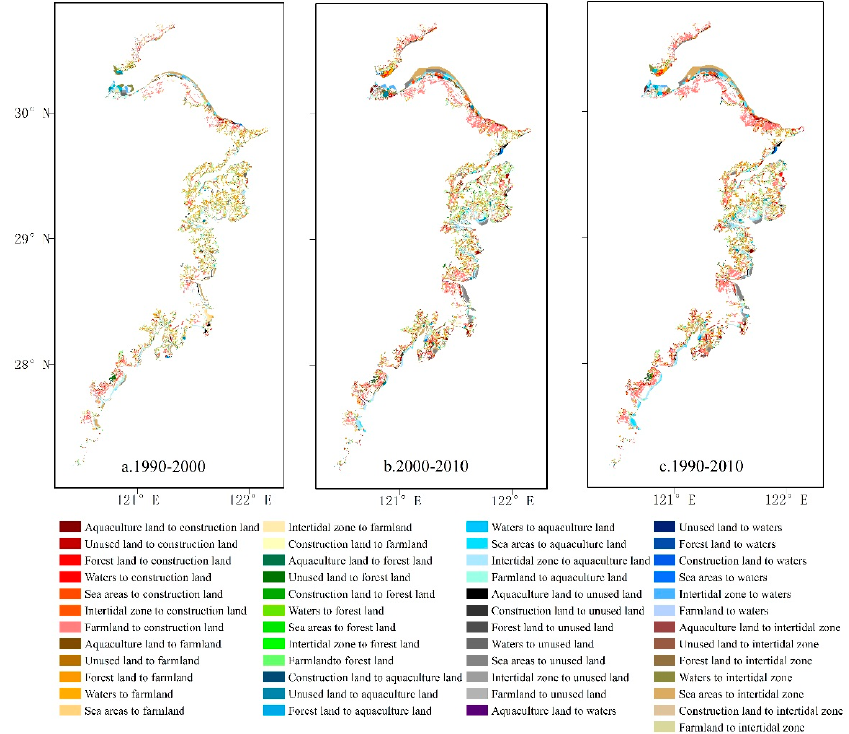
Figure 3. Land-use changes in the coastal zone in Zhejiang Province, 1990–2010. ( a ) land-use change from 1990 to 2000; ( b ) land-use change from 2000 to 2010; ( c ) land-use change from 1990 to 2010. Table 4. The change matrix of land use in the coastal zone in Zhejiang Province from 1990 to 2010.